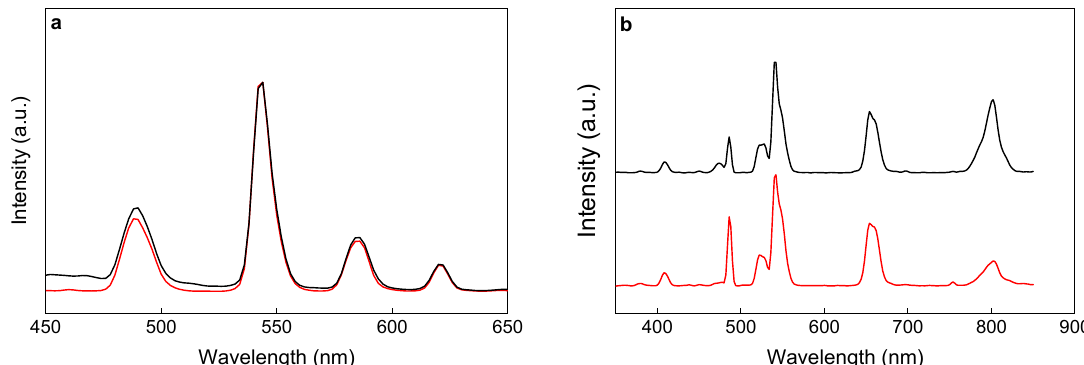
Figure 5. ( a ) DC and ( b ) UC photoluminescence emission spectra of P(DMA-AGME)-Ale-coated GdF 3 :Tb 3+ ,Yb 3+ ,Nd 3+ (red) and TbF 3 :Gd 3+ ,Yb 3+ ,Nd 3+ nanoparticles (black) excited at ( a ) 272 nm (for GdF 3 :Tb 3+ ) or 350 nm (for TbF 3 :Gd 3+ ) and ( b ) 980 nm; particle concentration 1 mg/mL and power density of up-conversion luminescence 5 W/cm 2 .